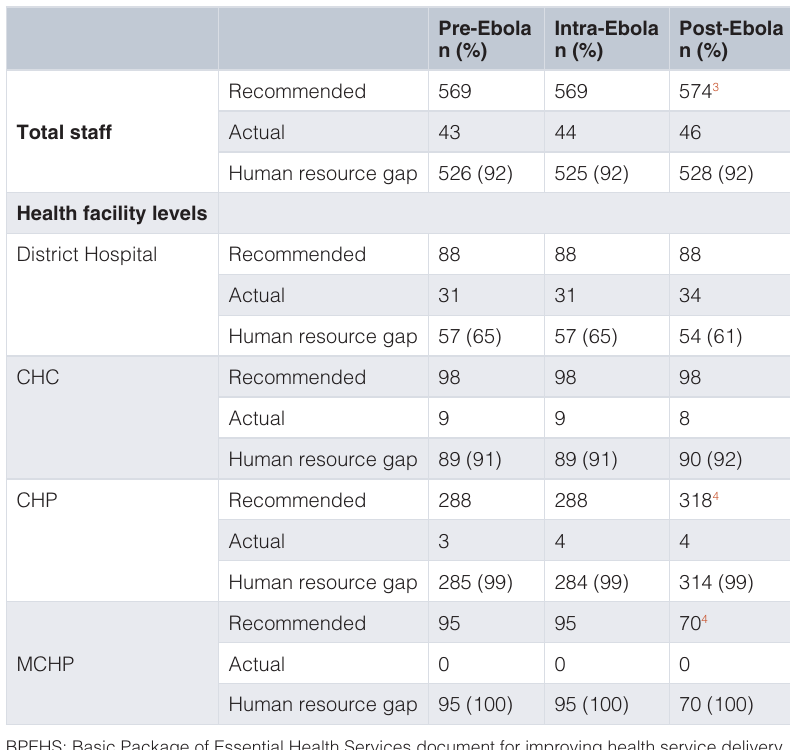
Table 2. Overall non-medical 1 staffing levels and gaps in relation to the recommended BPEHS standards assessed pre-, intra- and post-Ebola 2 in Kailahun district, Sierra